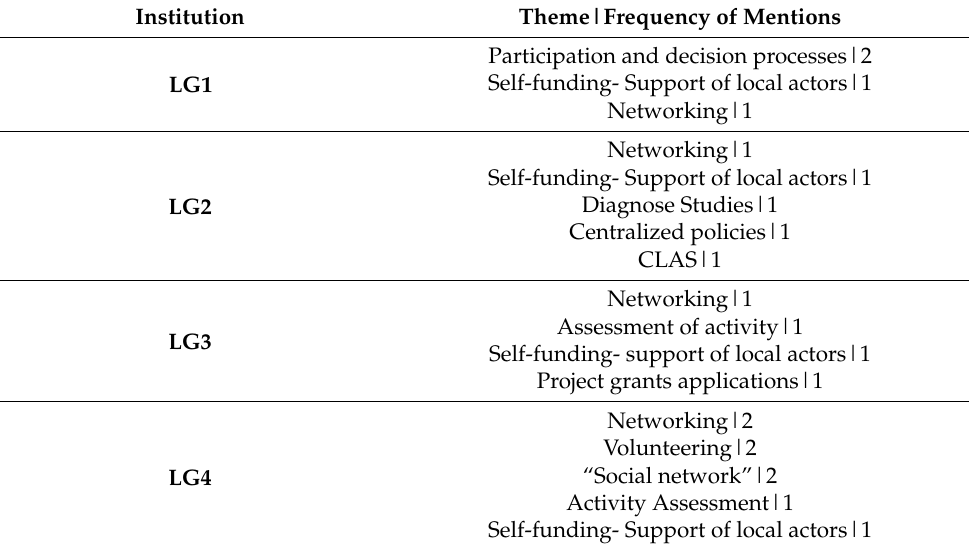
Table 4. Main vectors underpinning the process of age-related